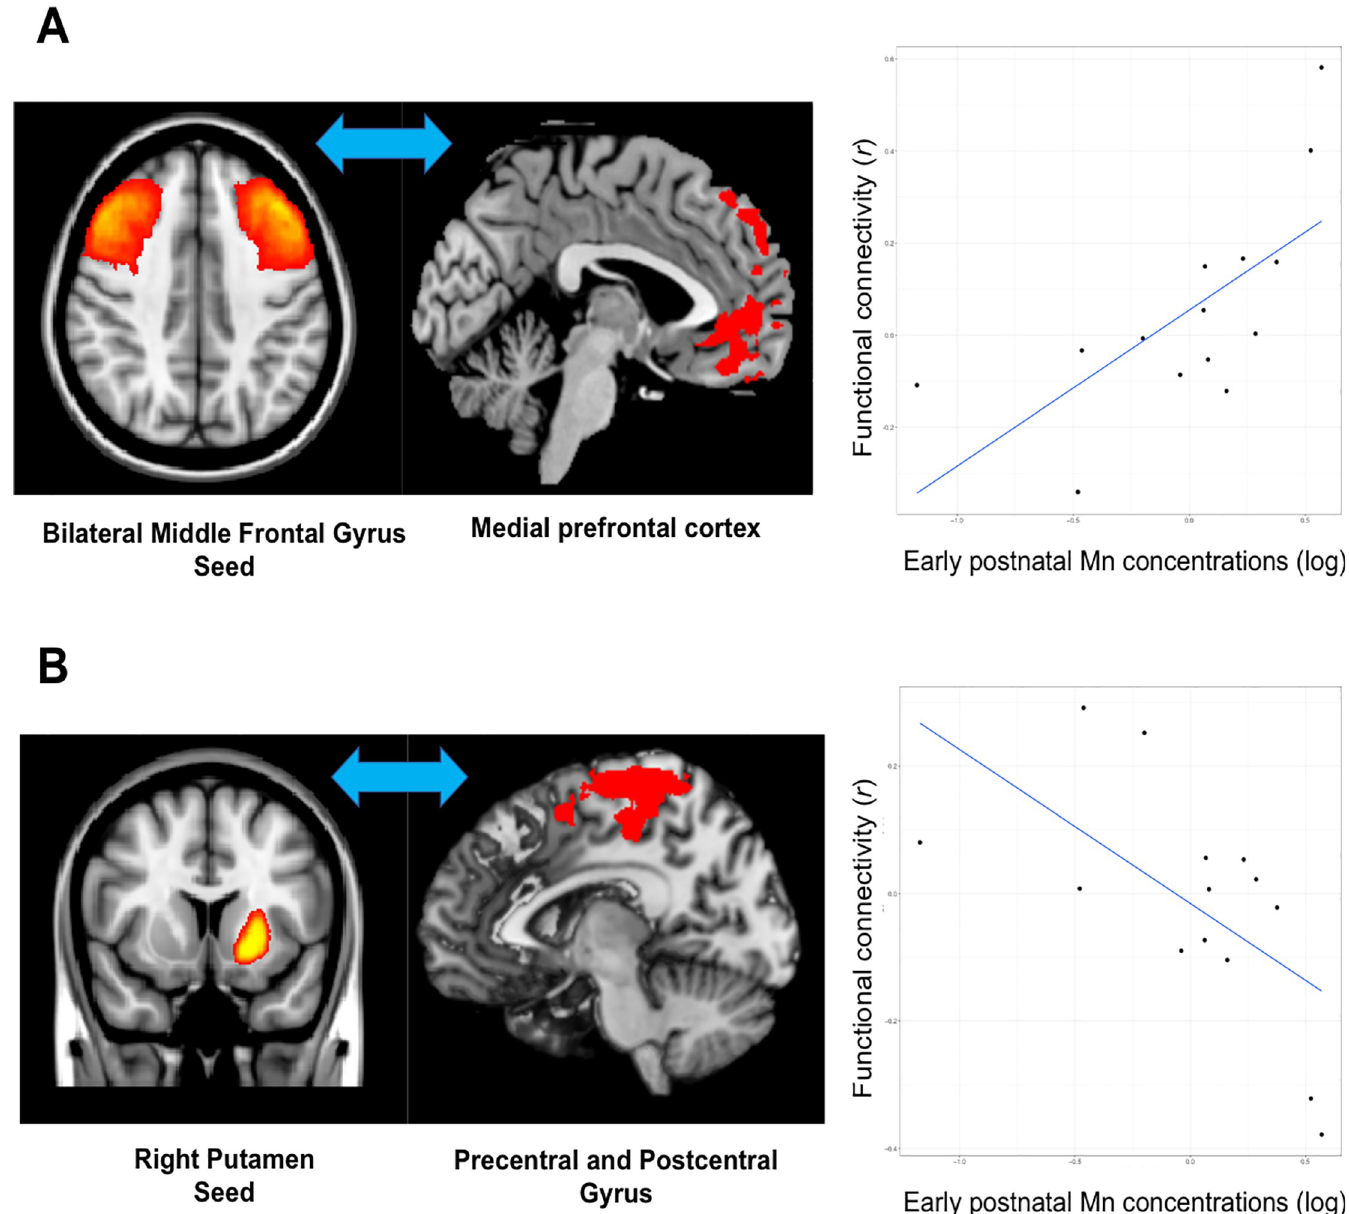
Fig 2. Results of seed-based correlation analyses. A) positive correlation (cluster-corrected p < 0.00238) between natural log-transformed early postnatal Mn concentrations and functional connectivity between the bilateral middle frontal gyrus and the left medial prefrontal cortex; B) negative correlation (cluster-corrected p < 0.00238) between natural log-transformed early postnatal Mn concentrations and functional connectivity between the right putamen and the left precentral and postcentral gyrus. Note . Mn = manganese. The Mn:Ca ratio was used to quantify concentrations to account for mineral variation between and within teeth.